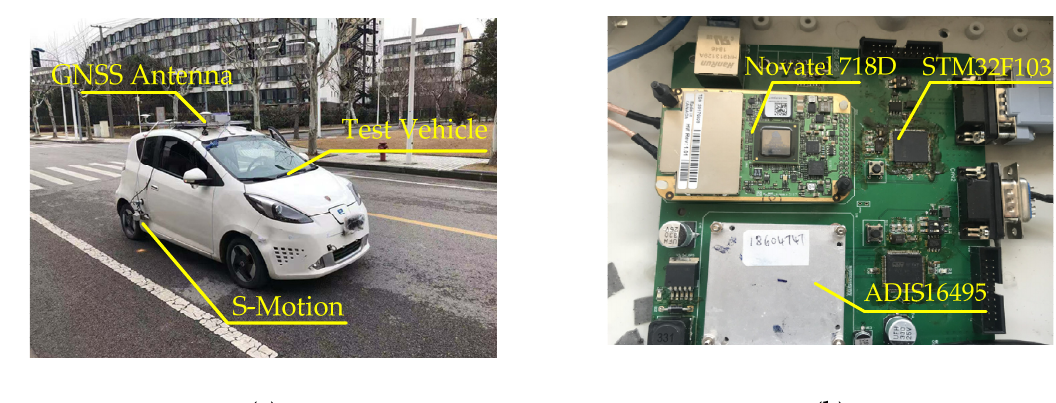
Figure 8. Hardware layout.